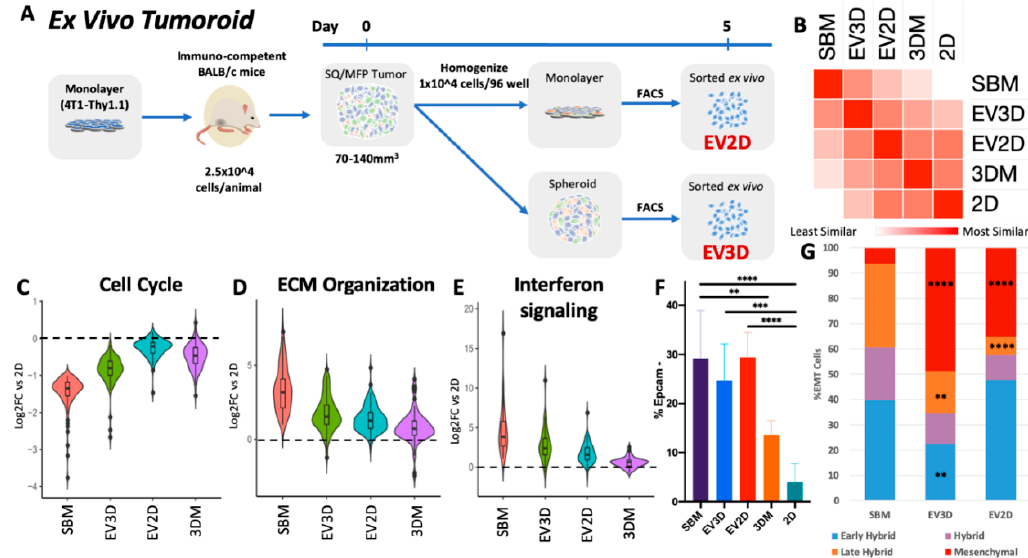
Figure 7. Ex vivo tumoroid culture encourages in vivo-like cancer cell behavior. ( A ) Ex vivo tumoroid culture experimental design. ( B ) Similarity matrix of 4T1 transcriptomic profiles across in vivo, ex vivo, and in vitro conditions. ( C ) Violin plot of magnitude of di ff erential expression of cell cycle DEGs of SBM vs. 2D across culturing conditions. ( D ) Violin plot of magnitude of di ff erential expression of ECM organization DEGs of SBM vs. 2D across culturing conditions. ( E ) Violin plot of magnitude of di ff erential expression of interferon signaling DEGs of SBM vs. 2D across culturing conditions. ( F ) Flow cytometric analysis of 4T1 cells undergoing EMT following 5 days of ex vivo culturing. ( G ) Abundance of hybrid EMT states following ex vivo culturing. Tumoroid conditions n = 6 from three independent tumors. * p < 0.05, ** p < 0.0005, *** p < 0.0005, and **** p < 0.0001 relative to